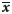
Concentration-time curves of VRC in tears after topical application of VRC solution or VRC-loaded nanofibers to the rabbit eye (n = 4, x¯±SD).